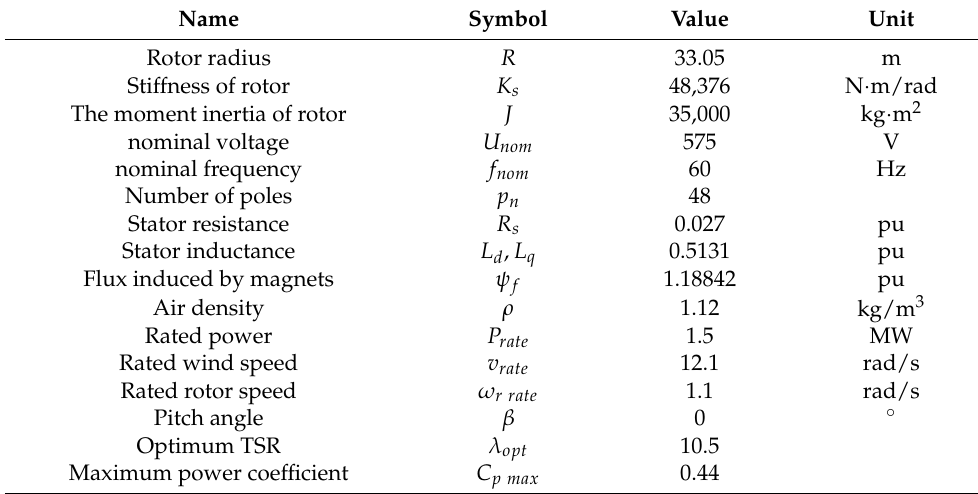
Table 1. Parameters of the 1.5 MW wind turbine